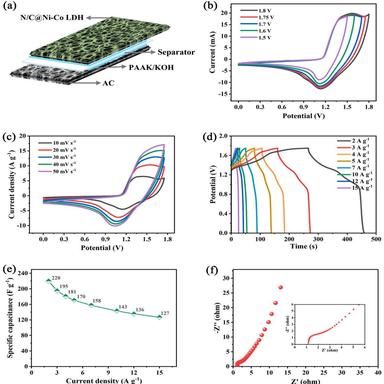
(a) The schematic structure of assembled N/C@Ni-Co LDH//AC ASC. (b) CV curves with different potential window at a scan rate of a scan rate of 20 mV s−1. (c) CV curves at different scan rates. (d) GCD curves with current densities from 2 A g−1 to 15 A g−1. (e) The specific capacitance of N/C@Ni-Co LDH//AC ASC at different current density. (f) EIS curves, (insert is the amplification of the high frequency region).